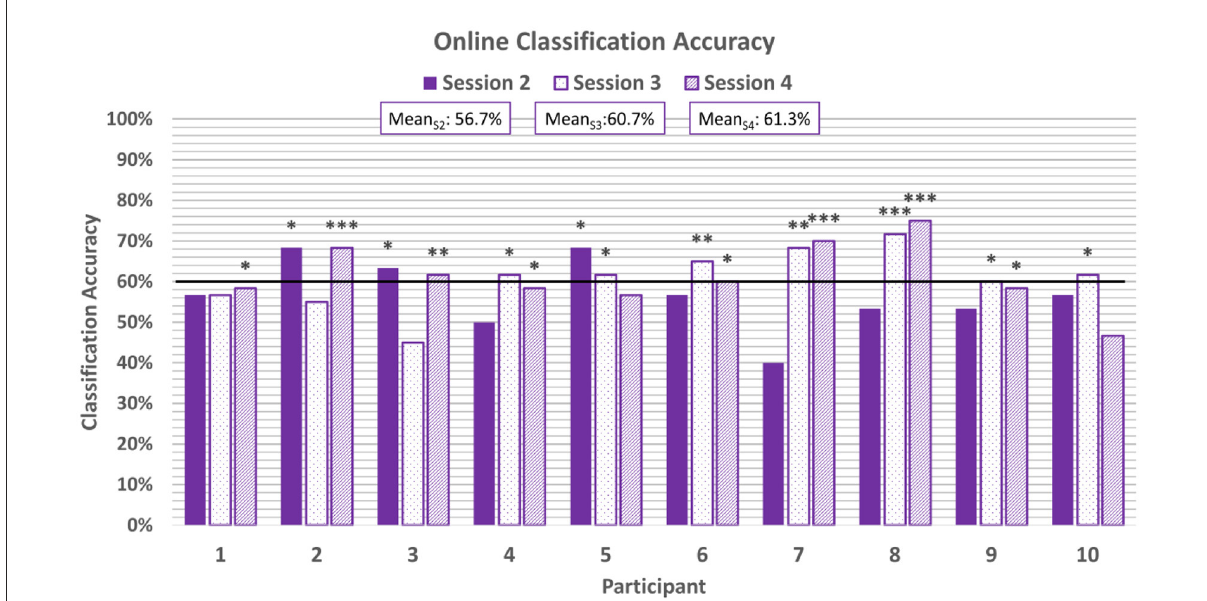
FIGURE5 Average classification accuracies for each online session. The horizontal line represents the 95% confidence level threshold for the first online session (based on n = 60 emotion-induction trials). Note that the 95% confidence level threshold drops down from 60% to 58% and 57% with each session as the amount of cumulative data increases (Müller-putz et al., 2008; Combrisson and Jerbi, 2015). Accuracies exceeding the upper limit of the 95%, 99%, and 99.9% confidence intervals of chance are marked with *, **, and ***, respectively.